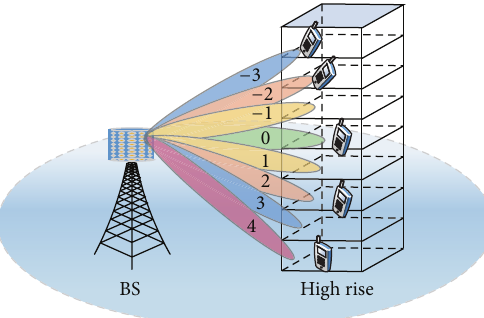
Figure 9: 3D beamforming covers the high rise